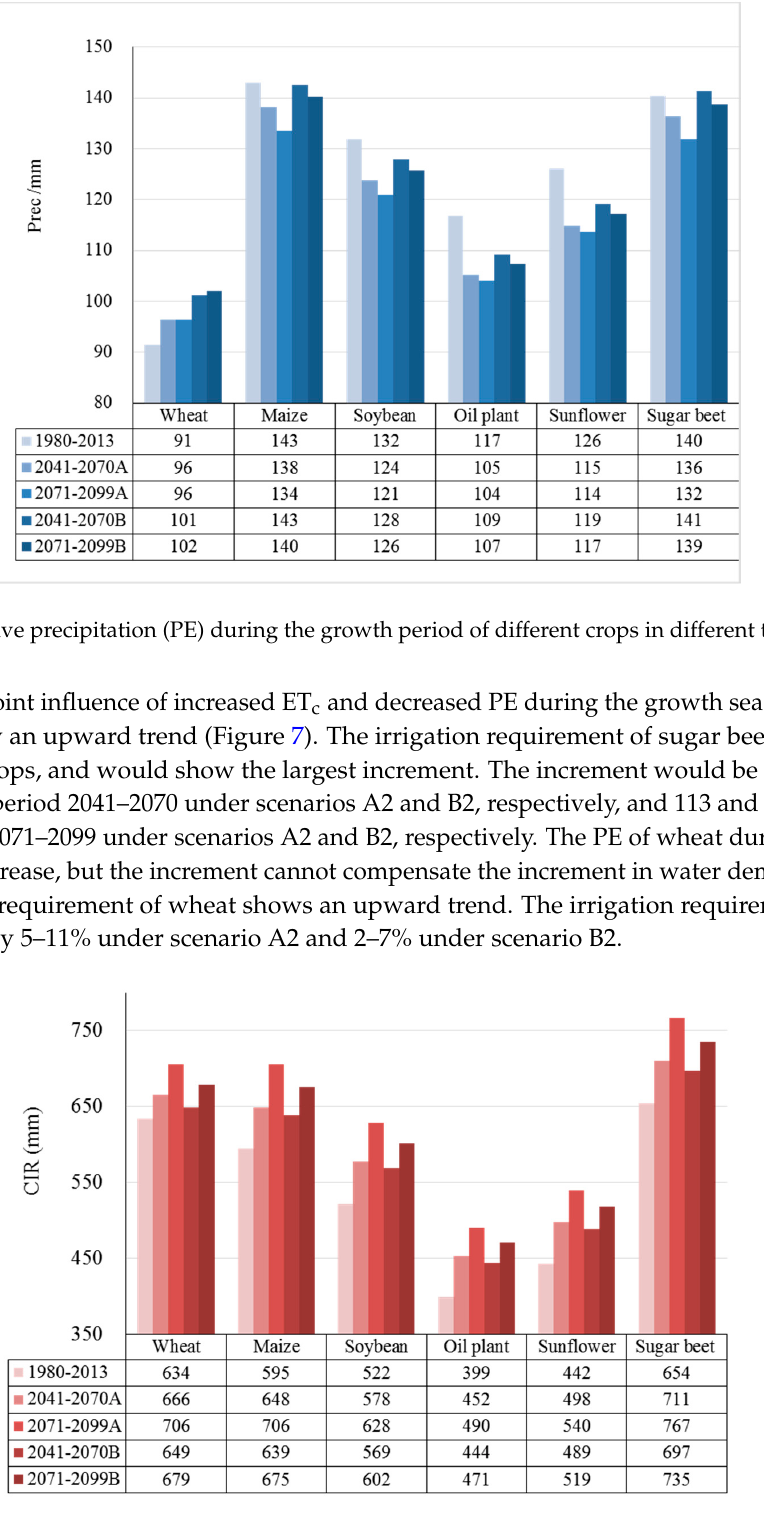
Figure 7. Crop irrigation Requirement (CIR) in different time periods.